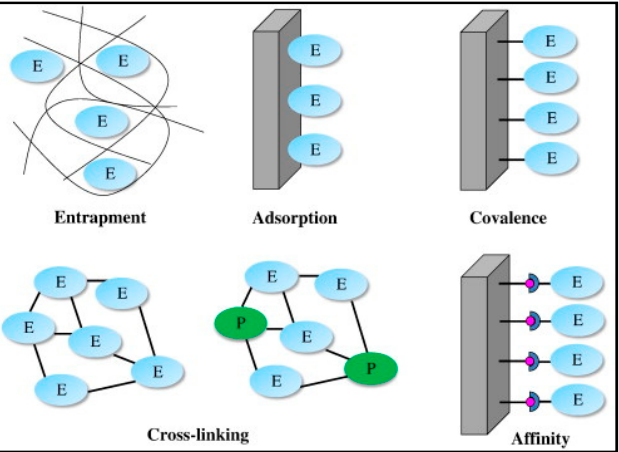
Figure 4. Schematic representation of main different methods for enzyme immobilization. Reprinted from [109] with permission of Elsevier.